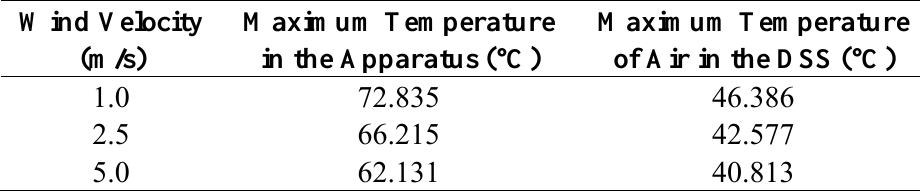
Table 3. Maximum temperature inside the apparatus and the DSS with different wind velocities (distance between apparatus and walls is 5 m, environmental temperature is 38 °C).